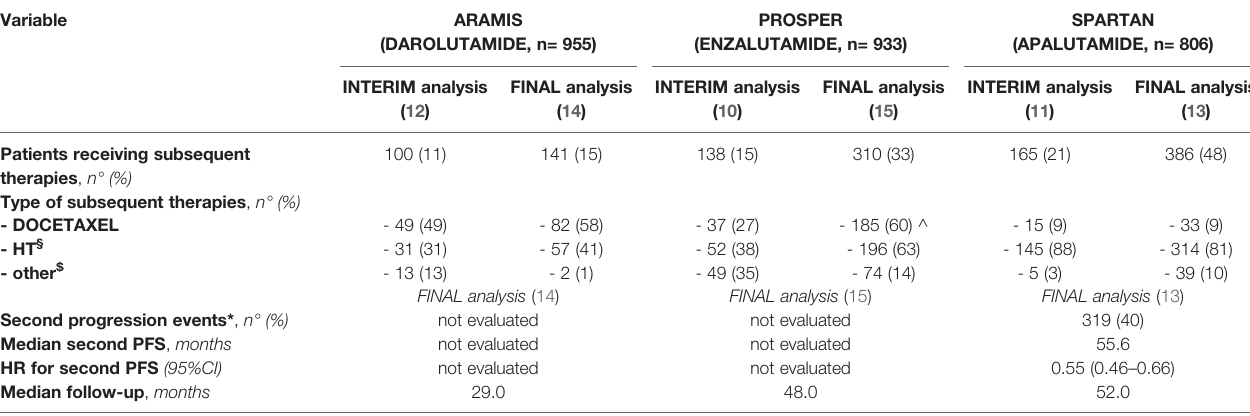
TABLE 3 | Second line therapies data from the fi nal analyses of the three included trials.